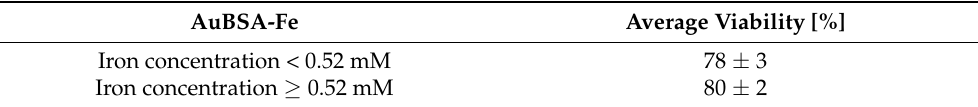
Table 3. Results of cell viability